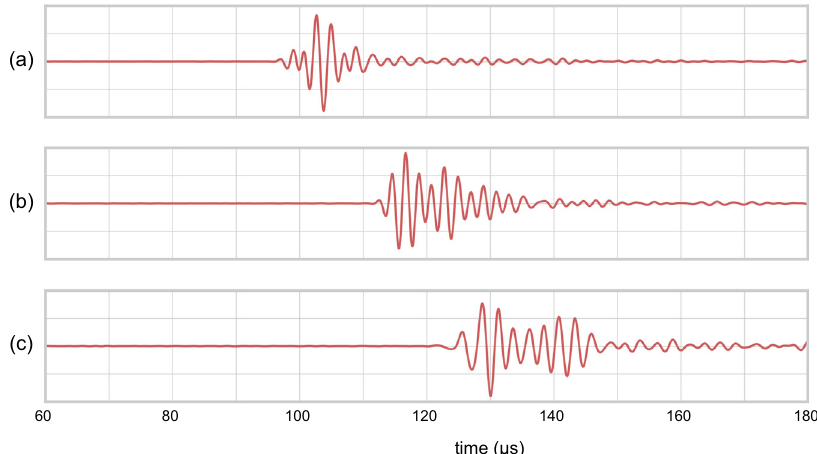
Fig. 6 In vivo transcranial observations. Un-processed, un-stacked, transcranial, ultrasound signals, low-pass fi ltered at 1 MHz, generated using a single source and single receiver, coupled to the subject using sonographic gel, and held fi rmly against the scalp and hair. The source waveform is identical to that used in both in silico and ex vivo experiments. The sonograms are amplitude normalised; true amplitudes and travel times are approximately proportional to source-receiver separation. a Temporal to temporal. b Left frontal to right occipital. c Frontal to parietal.